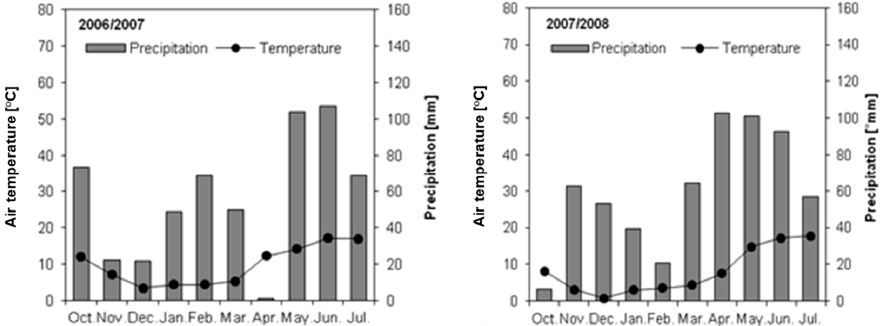
Figure 1. Air temperature ( ● ) and precipitation (bars) at the trial site Ihinger Hof for the growing seasons 2006/2007 and 2007/2008.